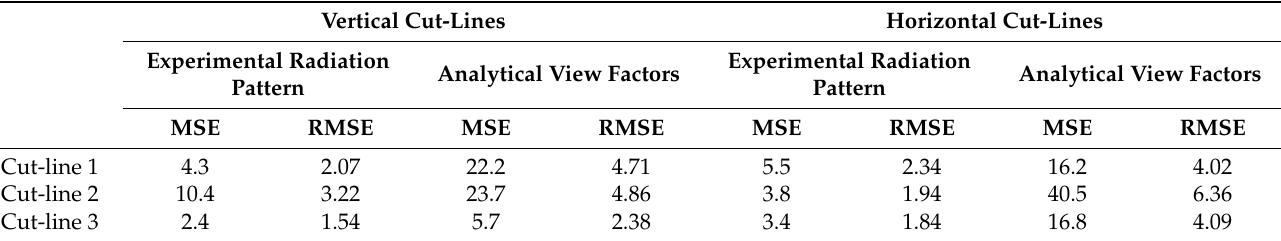
Table 3. Comparison of mean square errors along six cut-line in two methods.